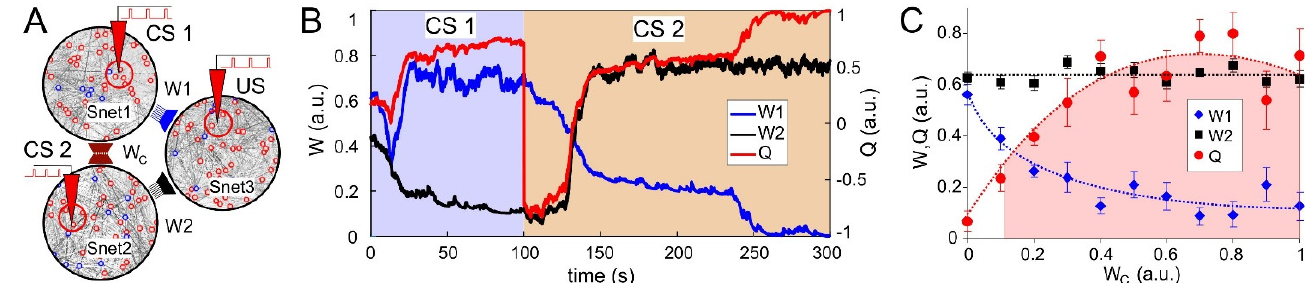
Figure 5. Associative learning due to synaptic competition. ( A ) Network architecture with internet- work connections W C implementing competition between subnets 1 and 2. The SNN provides asso- ciation of one of the conditional stimuli (CS 1 or CS 2) with unconditional stimulus US. ( B ) Dynamics of weights and the learning quality under conditional stimuli CS1 and CS2. Blue and orange areas correspond to associations CS1-US and CS2-US, respectively. ( C ) Average weights of internetwork connections W1 and W2 and the learning quality coefficient vs. average weights of internetwork connections W C .